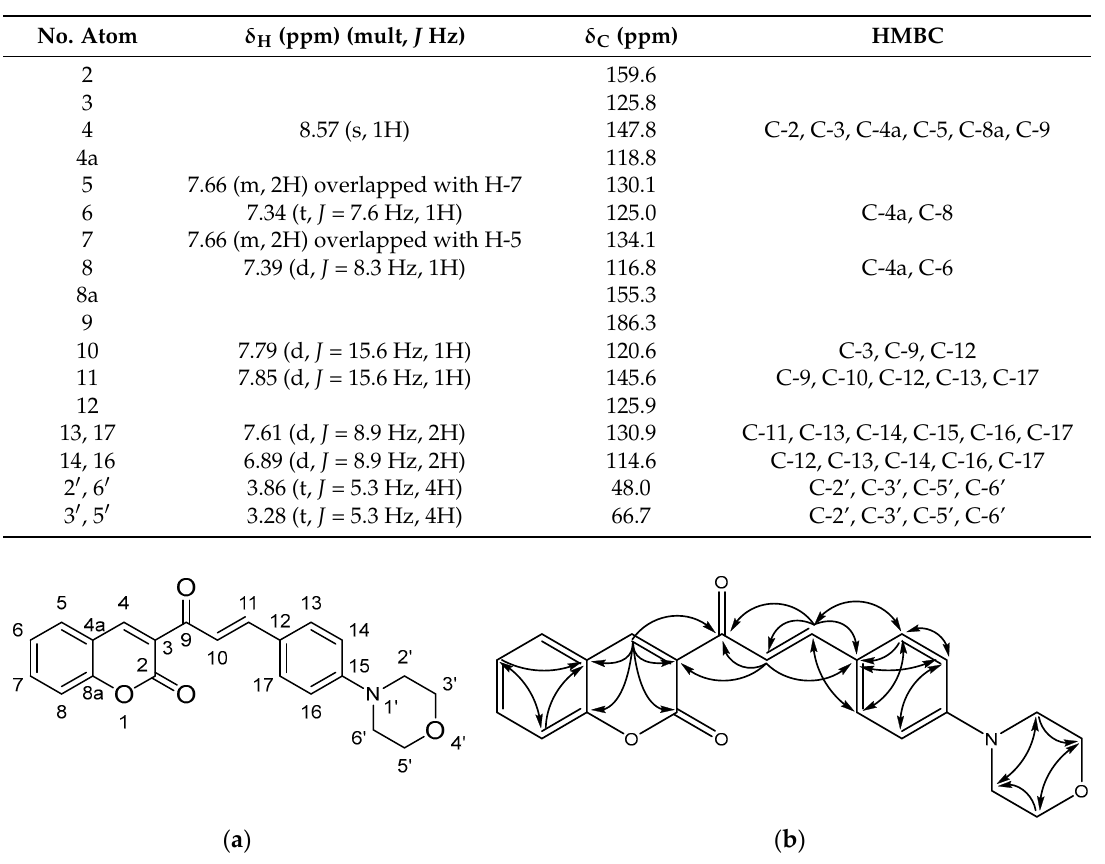
Table 1. NMR data of the title compound in CDCl 3 .